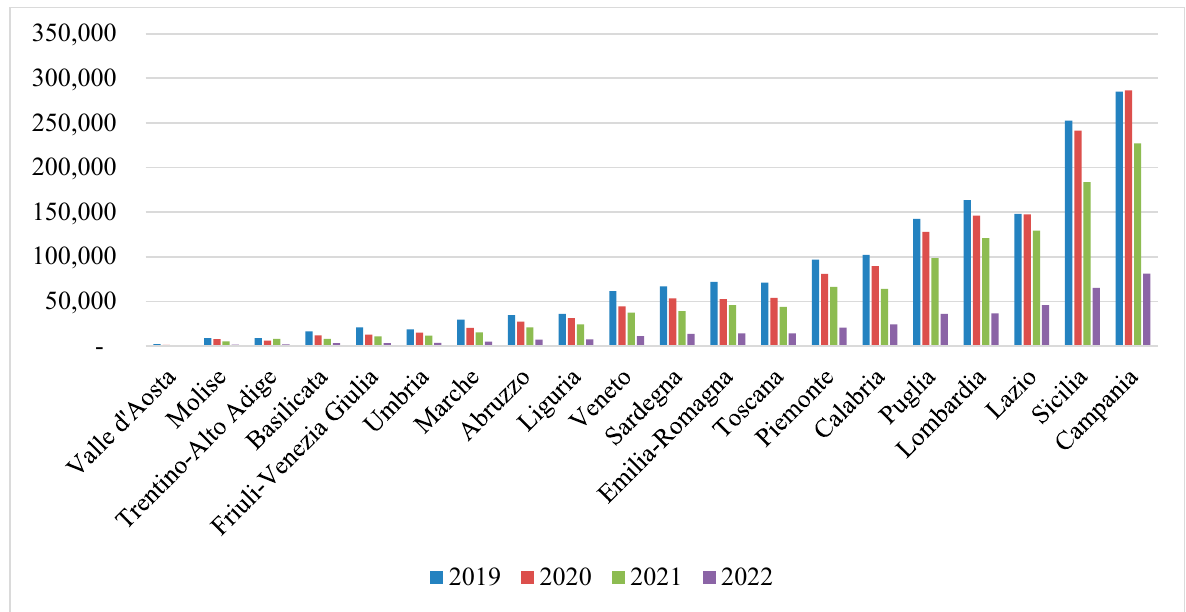
Figure 12. Citizenship Income household recipients by year and region, 2019–2022. Note: